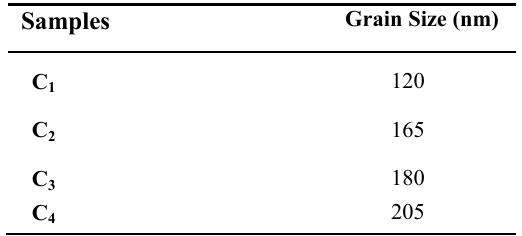
and (b) sample C . 1 4